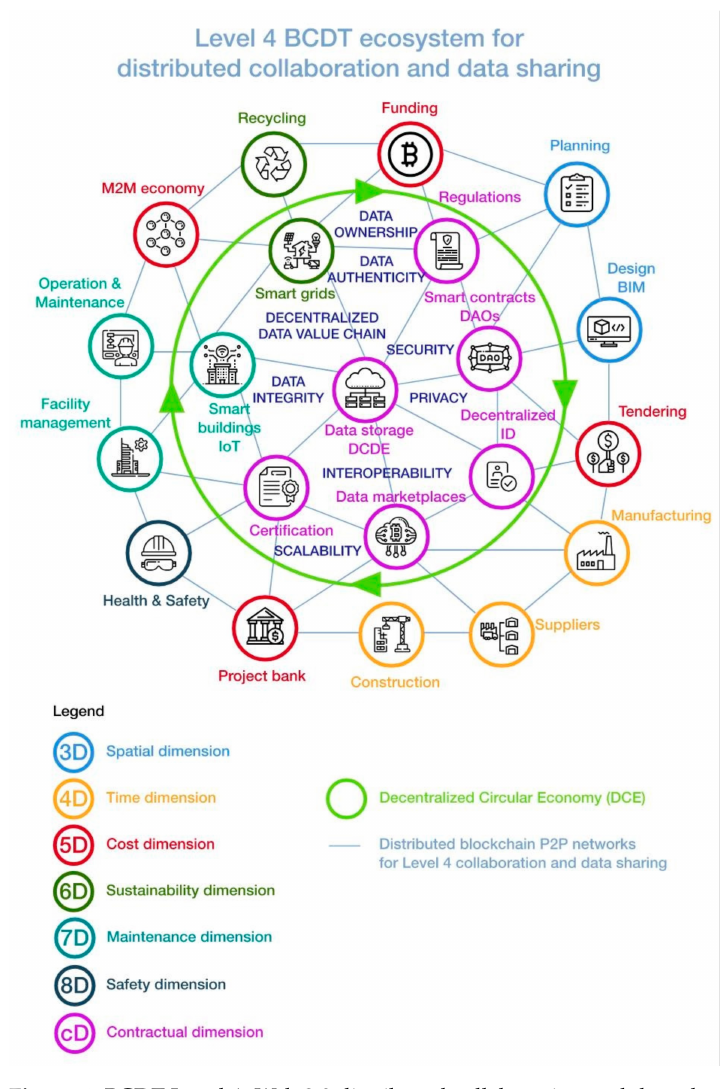
Figure 4. BCDT Level 4: Web 3.0 distributed collaboration and data sharing for CI